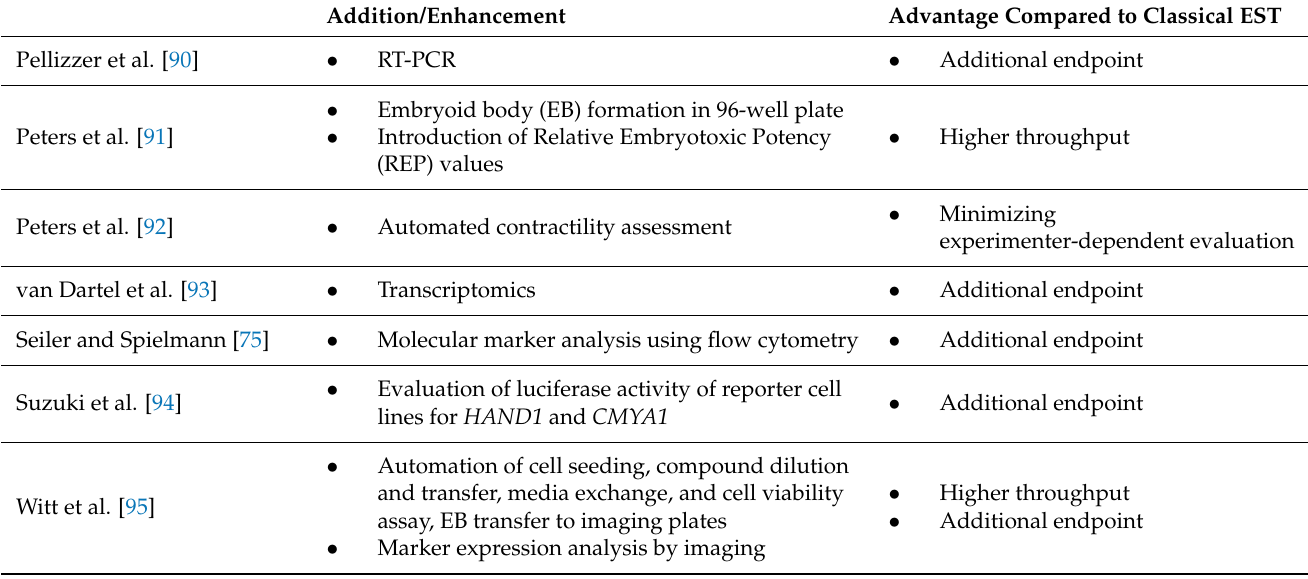
Table 3. Past additions and enhancements to the classical embryonic stem cell test (EST) [74] to improve the test system.